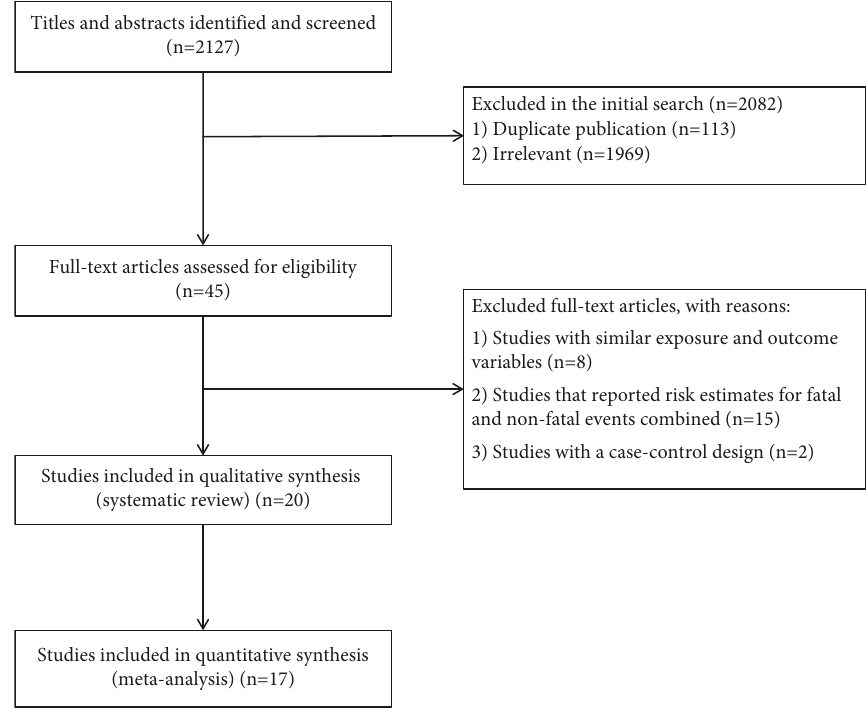
Figure 1: Flow diagram of study